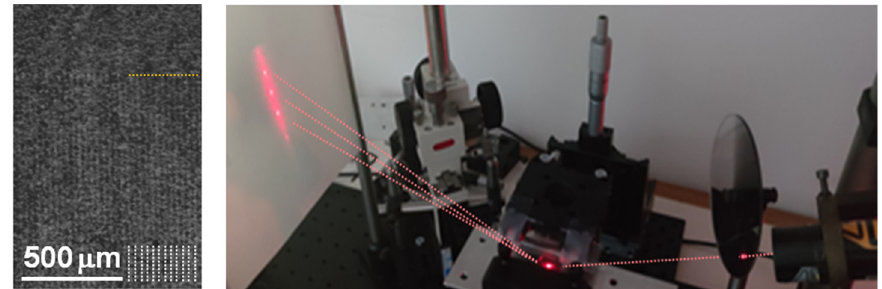
Figure 2. ( left ) Optical microscopy image of the micropatterned surface area. White vertical lines indicate grating lines. The border between the patterned and nonpatterned regions is indicated by a yellow horizontal line. ( right ) Photo of the experimental setup with a typical diffraction image projected onto a white screen. Red dotted lines indicate the paths of the incident and diffracted optical beams.